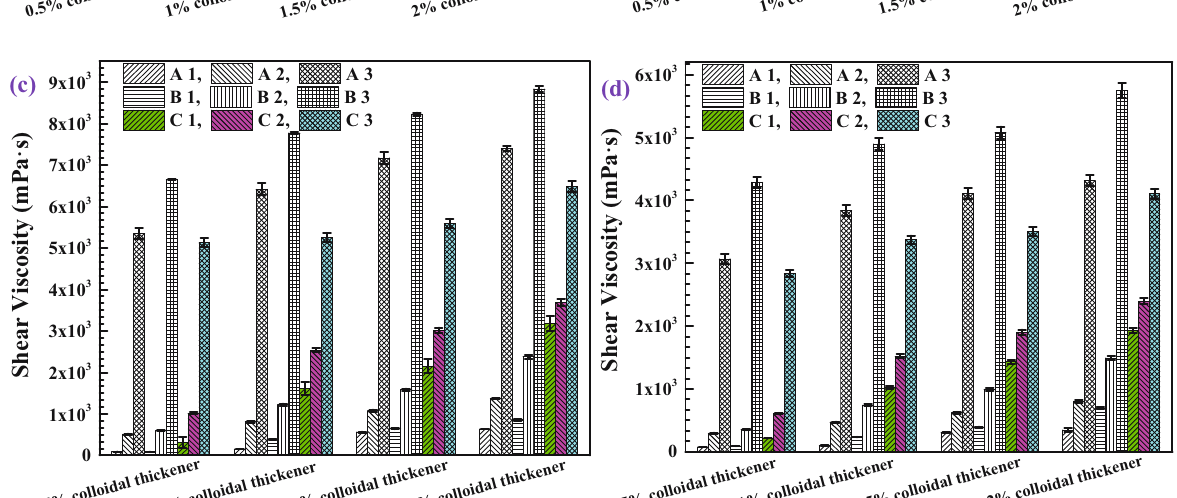
same shear rate at di ff erent mass percentage concen - trations, which indicates that the thickening liquid has shear viscosity that is more a ff ected by the type of dispersion medium than by the concentration of the thickener. Figure 5 shows that at the same shear rate, the same type of dispersion medium, and the same concentration, the shear viscosity of the thick - ening liquid decreases sequentially from GG, XG, to TBG. In Figure 5, under the same dispersion phase, dispersion medium type, and the same thickener con - centration, the thickening liquid ’ s shear rate from 6, 10, 20, to 40 s 1 − , the shear viscosity of the thickening liquid decreases gradually, which is consistent with the conclusion of the analysis of shear viscosity and shear rate.